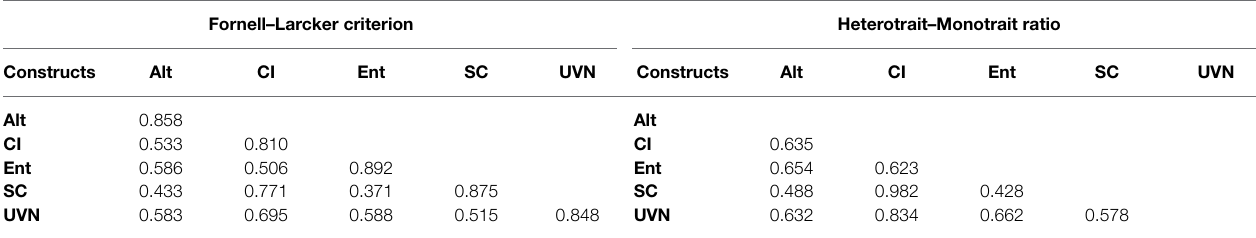
TABLE 3 | Discriminant validity.